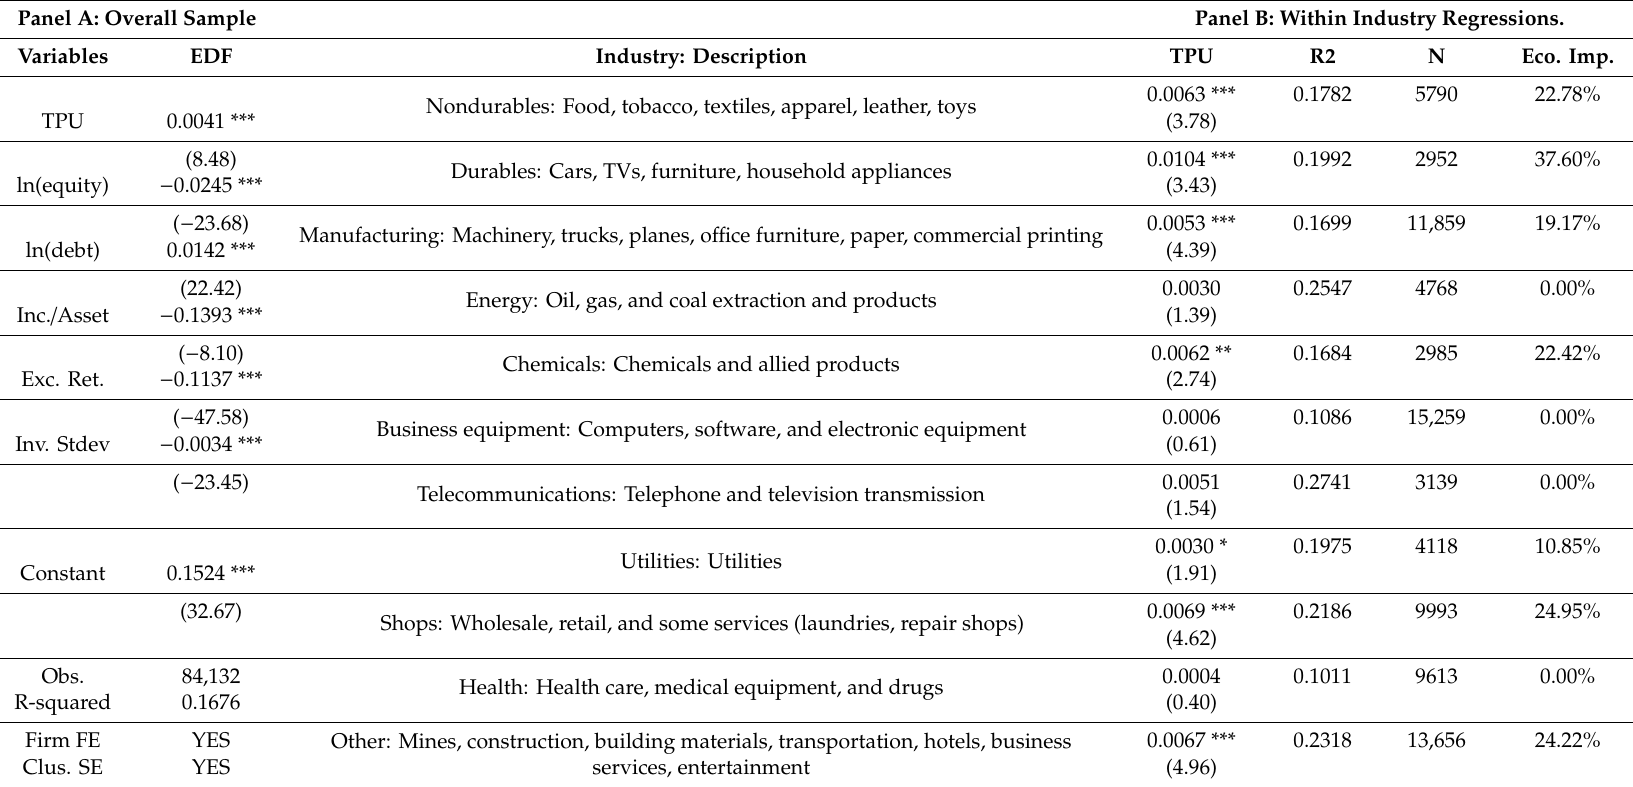
Table 2. Tax policy uncertainty and default risk fixed e ff ect analysis—this table presents firm fixed e ff ects regression results for the impact of tax policy uncertainty on default risk. The sample has 9888 unique firms and 84,132 firm-year observations from 1987 to 2019. In all models, the dependent variable is the expected default frequency ( EDF ). The main variable of interest tax policy uncertainty (TPU). Panel A presents the results for the overall sample. Panel B reports the coe ffi cients for the TPUs from the regressions with EDF as the dependent variable for each of the Fama and French 12 industries. The last column (Eco. Imp.) reports the economic impact of a standard deviation increase in TPU on default risk on a relative basis. Variables are defined in Appendix A. T -statistics reported in parentheses are calculated using standard errors that are clustered at the firm level and are robust to heteroskedasticity. Symbols *, **, and *** indicate statistical significance at 10%, 5% and 1% levels,